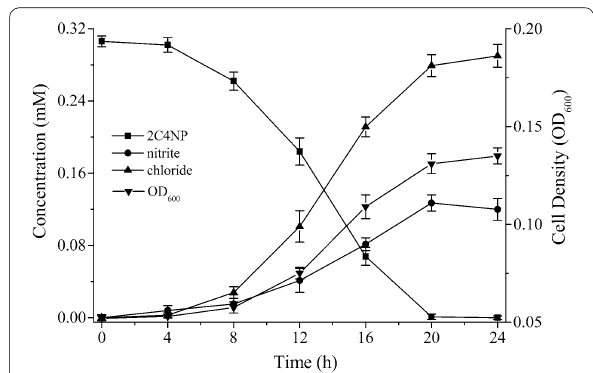
Fig. 1 Degradation of 2C4NP by Cupriavidus sp. strain CNP-8, together with the accumulation of nitrite, chloride and the bacterial biomass (indicated by OD 600